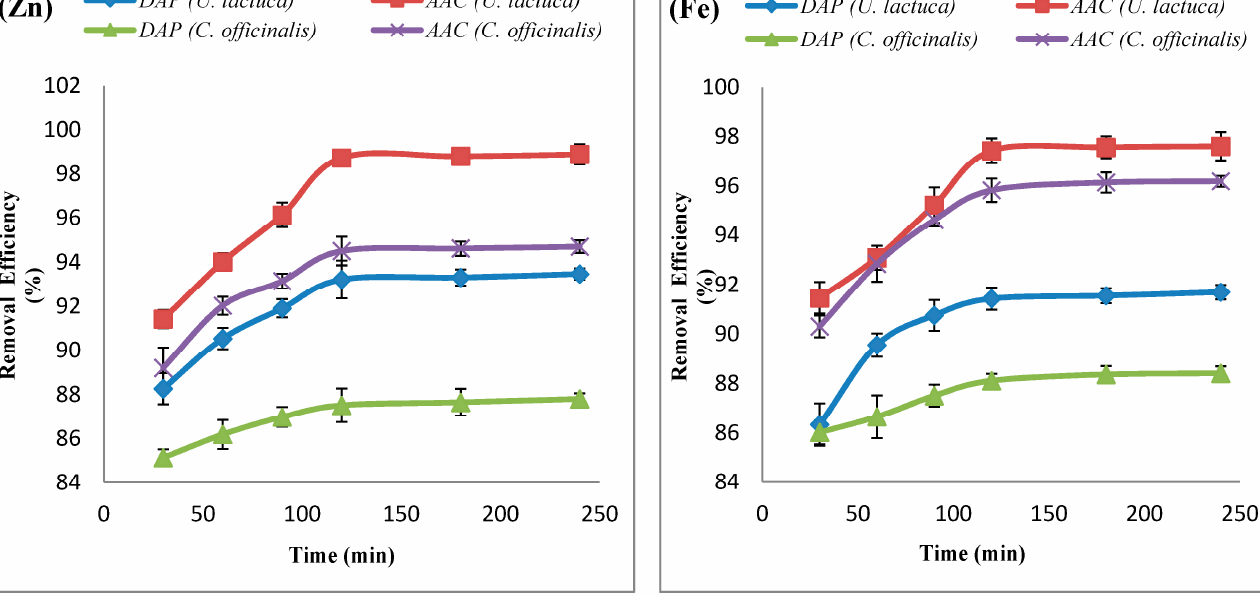
Figure 3. Effect of pH on the percentage of removal of Zn +2 and Fe +3 (at 120 min.by using 50 mg.L − 1 metal-ion concentration and 1.0 g.L − 1 ) using dried algal powder (DAP) and the activated carbon (AAC) of both U. lactuca and C. officinalis. Each data point represents the mean ± SD. Effect of initial concentration of metal ions An inspection of Figure 4 reveals that the initial concentration of metal ions was in- versely related to the removal efficiency. As the initial metal-ion concentrations increased from 10 to 50 mg.L − 1 , the removal efficiencies decreased from 97.1% to 93.2% and from 96.8% to 91.4% for Zn +2 and Fe +3 , respectively, using dried U. lactuca, and decreased from